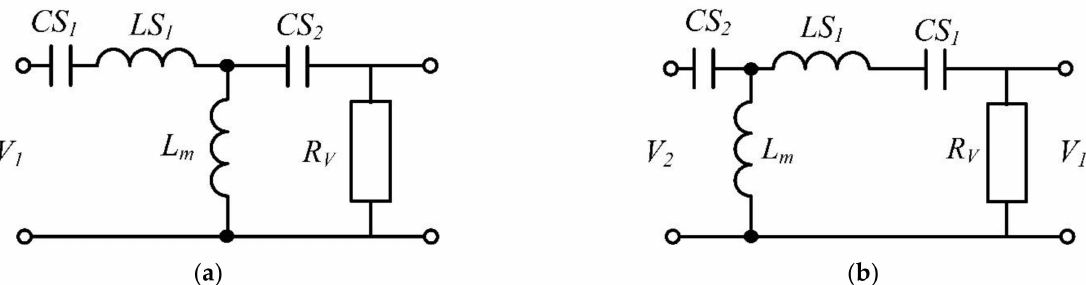
Figure 7. Equivalent circuit of the bidirectional full-bridge LLC resonant converters using the ( a ) MT-4 and ( b ) MT-11 resonant